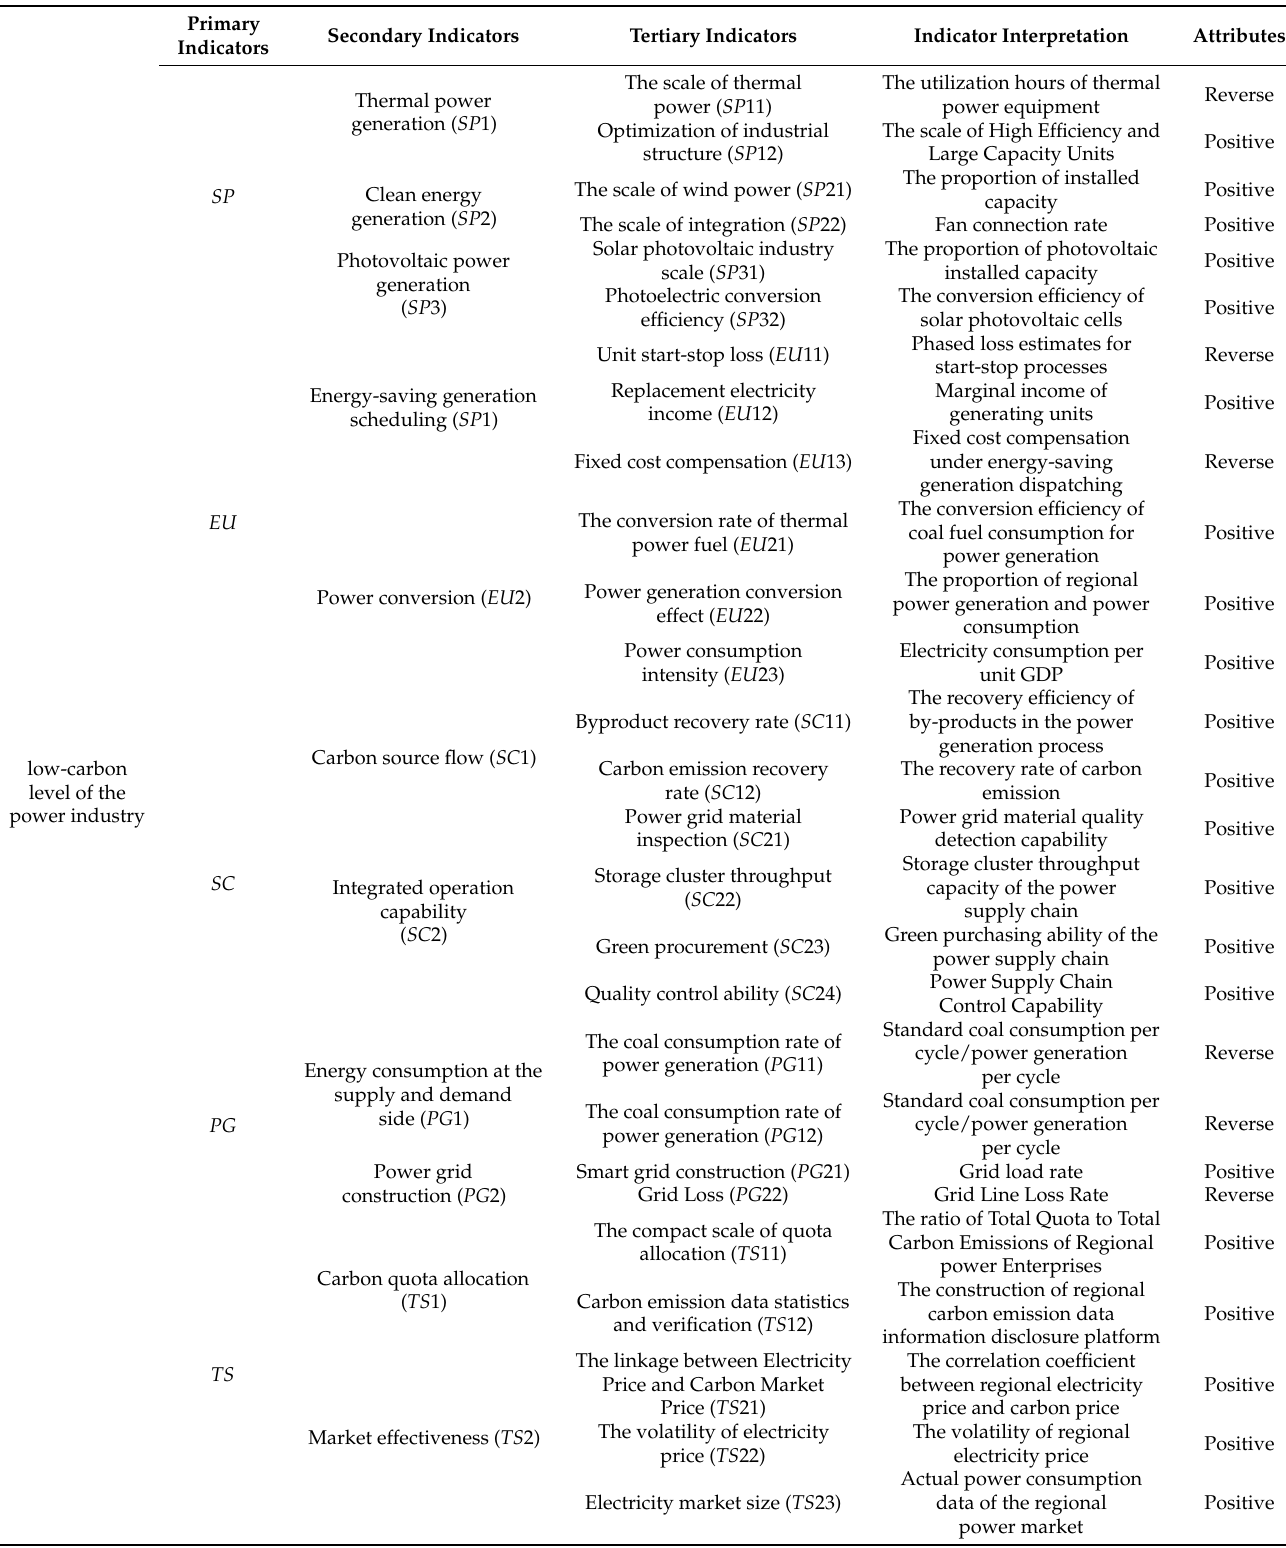
Table 1. Evaluation index system of the low-carbon level of the power